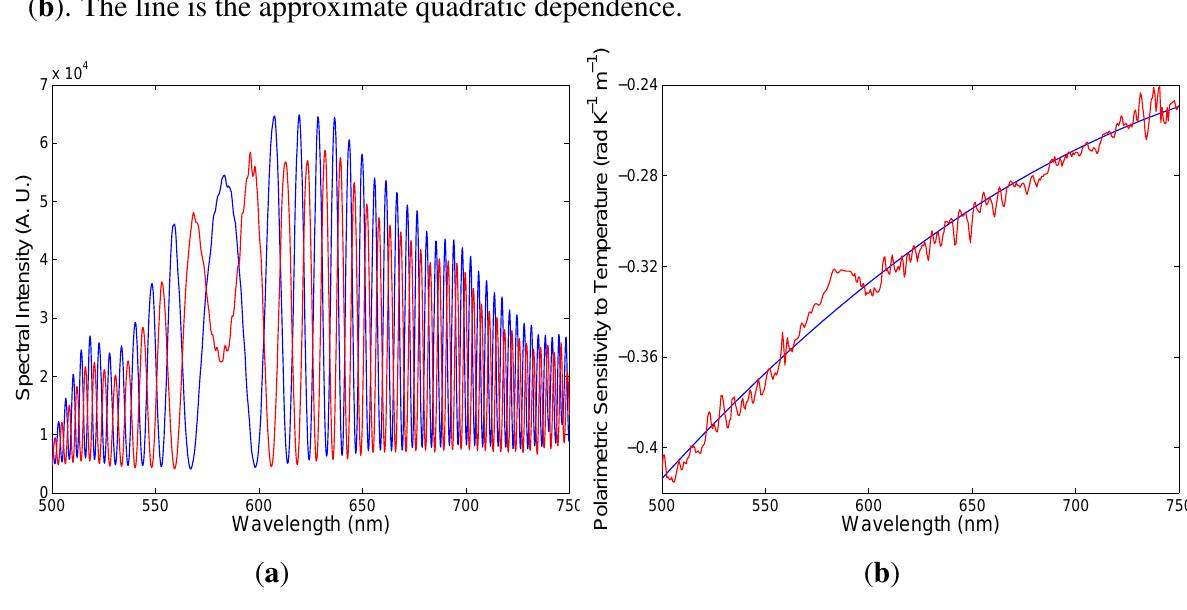
= 297 K (blue) and 1